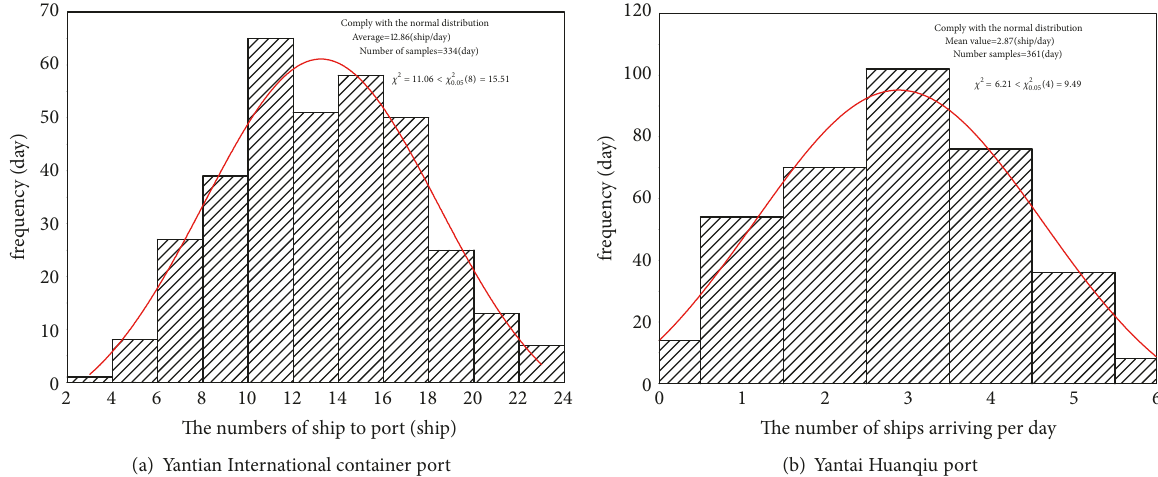
Figure 10: Normal distribution of the number of arrival